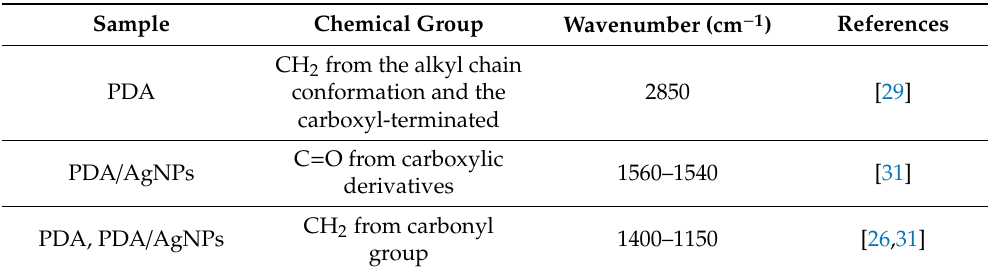
Table 2. Vibration modes and band frequencies in polydiacetylene (PDA) and PDA / silver nanoparticles (AgNPs) embedded in CMC